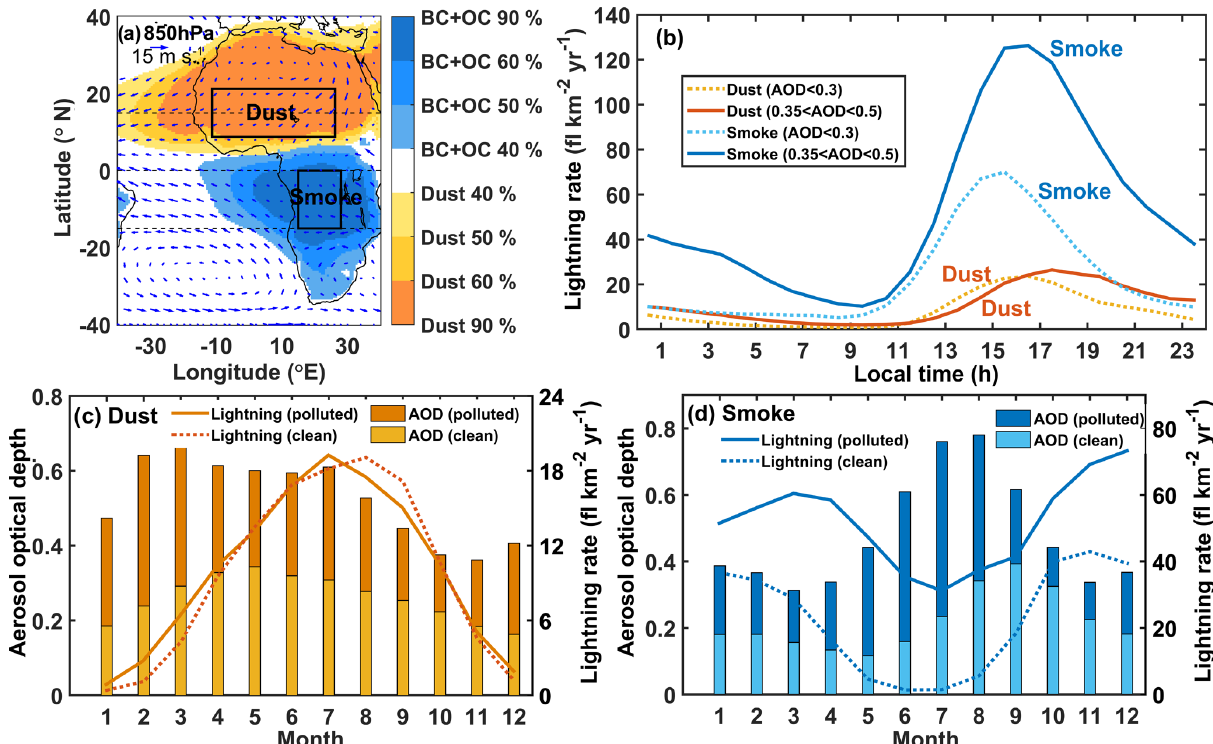
Figure 2. (a) The 850hPa mean wind field from the ERA-Interim reanalysis with a spatial resolution of 1 ◦ × 1 ◦ showing the prevailing wind direction over Africa and the neighboring ocean over the region of interest defined in Fig. 1. The dust- and smoke-dominant regions (outlined by black rectangles) are defined as areas where the ratio of dust or carbonaceous aerosol (black carbon and organic carbon: BC + OC) extinction aerosol optical depth (AOD) to total extinction AOD is greater than 50% averaged over the period from 2003 to 2013, which enables us to better understand the potential effect of dust or smoke aerosols on lightning. Also shown are the (b) diurnal cycle and monthly variations in mean AOD and lightning flash rate calculated under relatively clean and polluted (dusty/smoky) conditions in the (c) dust- dominant region and the (d) smoke-dominant region. Unless otherwise noted, the AOD used in this study is derived from the MODIS, and the lowest (highest) third of the AOD range (AOD ∈ (0, 1)) is labeled as clean (polluted). Lightning flash rates come from the low-resolution monthly time series and the low-resolution diurnal climatology products on a 2.5 ◦ × 2.5 ◦ grid (Cecil et al., 2001, 2006, 2014). Data from all seasons are